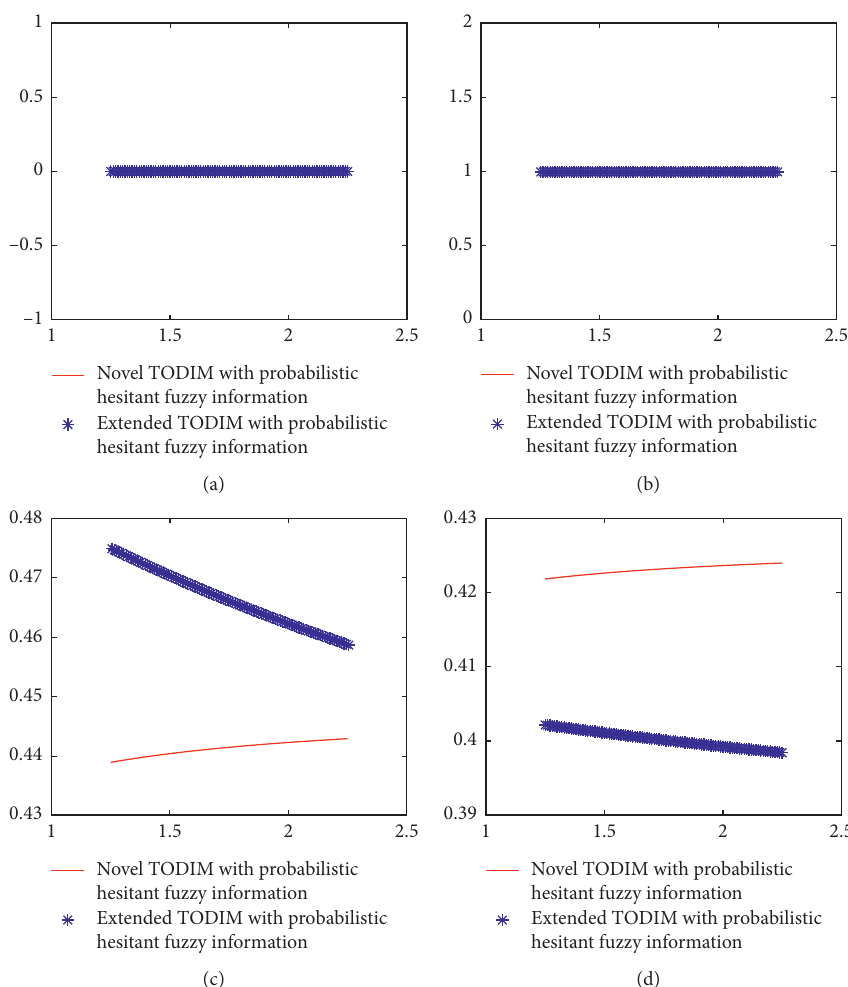
Figure 2: Sensitivity analysis with probabilistic hesitant fuzzy information. 1 . 25 ≤ λ ≤ 2 . 25, α � β � 0 . 88, δ � 0 . 69, and c � 0 . 61. (a) A A 2 ; (c) A 3 ; (d) A 4